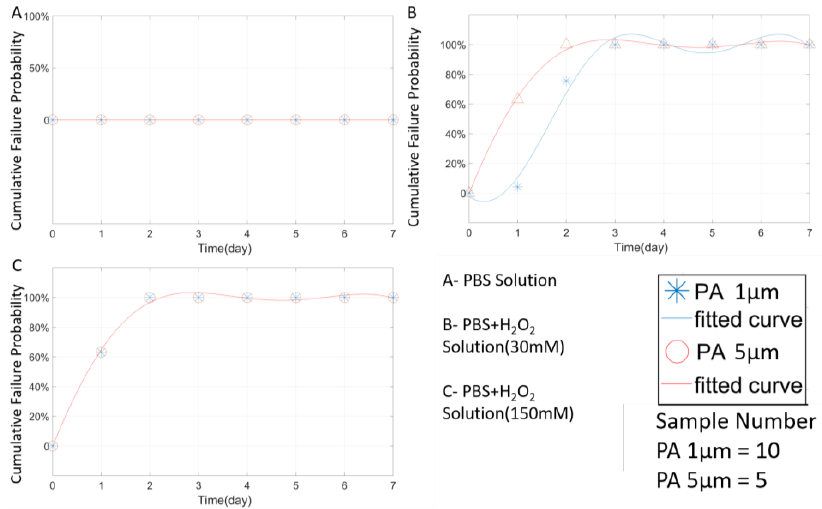
Figure 15. The Weibull cumulative distribution data and corresponding curve fitting of open-tip samples with 1 µ m and 5 µ m PA coating. Experiments were performed in di ff erent solutions at a temperature of 67 ◦